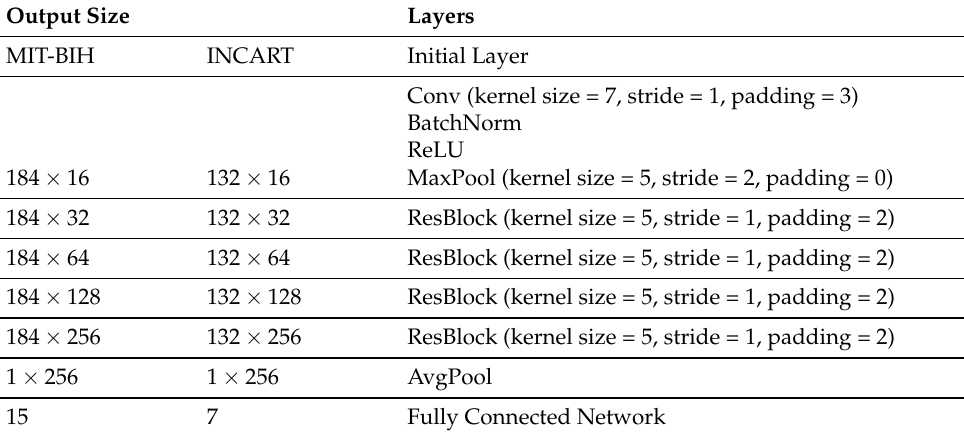
Table 5. Architecture of 1-D ResNet with the parameters for the initial layer and the convolutions of each residual